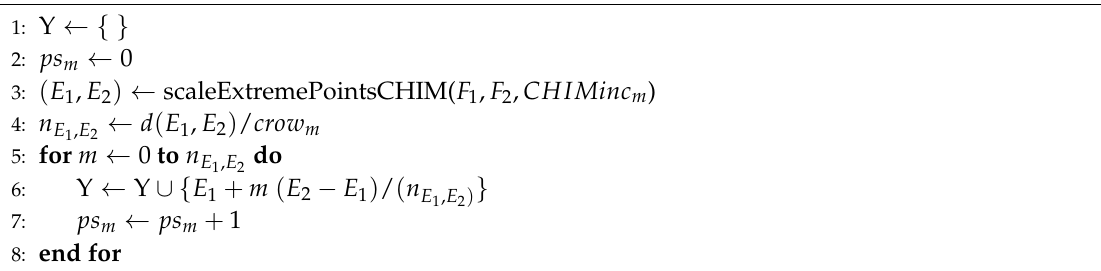
Algorithm 1 Distribution of the reference points for two